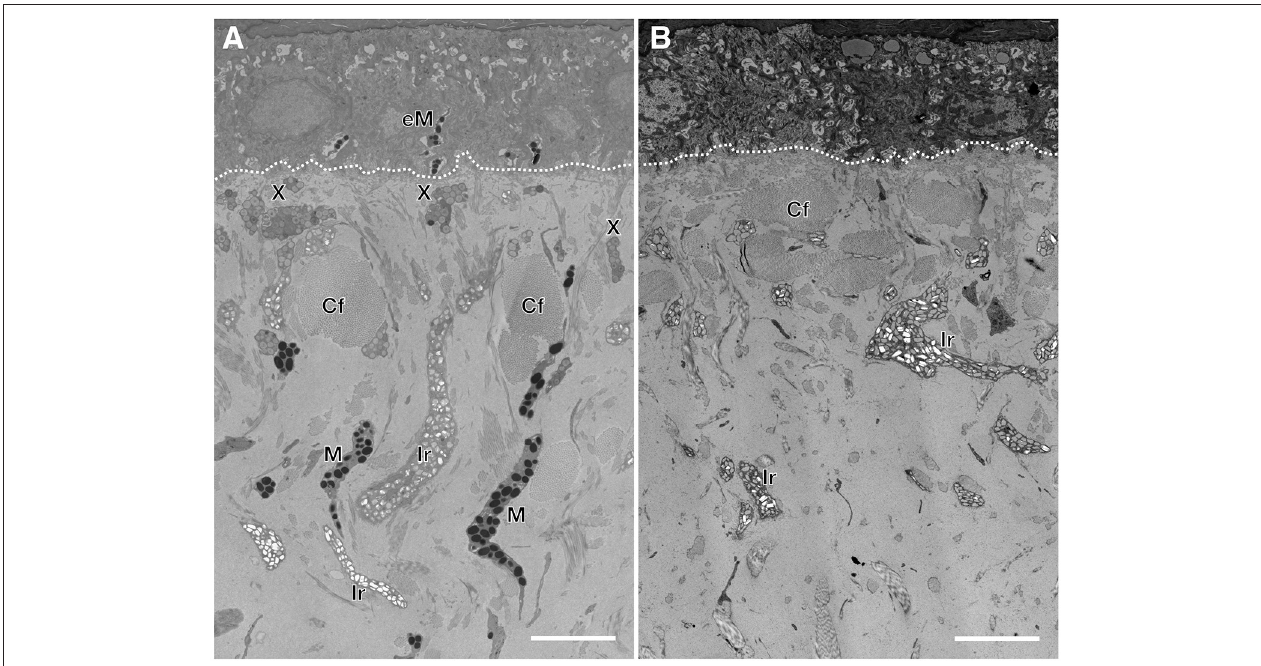
FIGURE 2 | Semi-thin sections of wild type (A) and leucistic (B) Texas rat snake dorsal skin. In the wild type, xanthophores (X) are situated closer to the basal membrane (dashed line) whereas the iridophores (Ir) and the melanophores (M) are spread in the loose dermis among collagen fibers (Cf). In the leucistic skin, only iridophores and collagen fibers are observed. Epidermal melanophores (eM) are observed only in the wild type. Scale bar: 5 µ m.